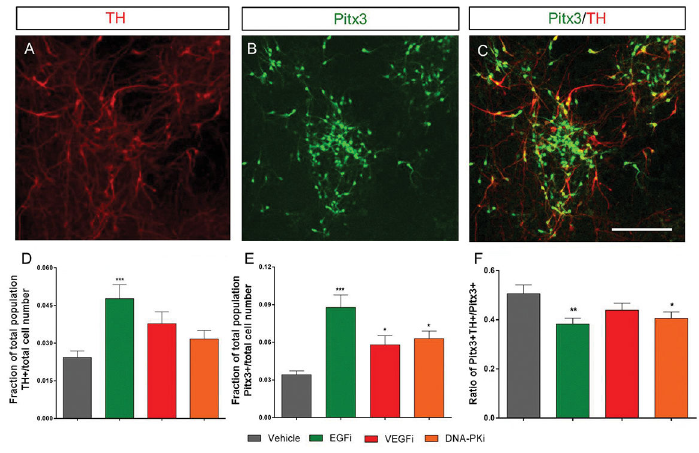
Figure 7. Small molecules can promote the specification of specific post-mitotic phenotypes. Neural progenitors incubated with SMAs gave rise to TH+ (A), Pitx3+ (B) and TH+/Pitx3+ neurons (C) by day 19 of differentiation. Pitx3 expression was determined using from residual GFP expression after fixation of cells produced by differentiating the Pitx3 - eGFP mESC line, whereas visualization of TH was achieved using the secondary antibody anti-Rabbit AlexFluor594 binding to a Rabbit anti-TH primary antibody. Column bars show mean ± SEM fraction of Pitx3+ (D) and TH+ (E) cells present in each field of view, expressed as a fraction of the total cell counts (n = 35-36 fields of view from four replicate experiments). ***p<0.001 **p<0.01 and *p<0.05 respectively, using one-way ANOVA compared to vehicle with Dunnett’s multiple comparisons. Scale 100